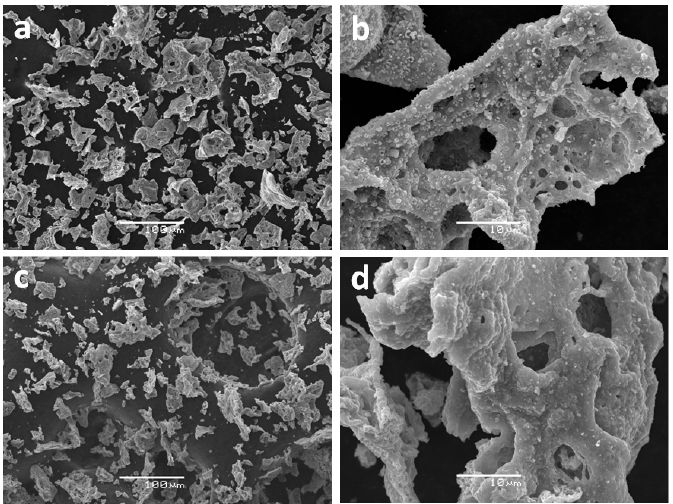
Figure 1. The SEM images of ( a , b ) copper ferrite (CuFe-1) and ( c , d ) cobalt ferrite (CoFe) prepared by combustion